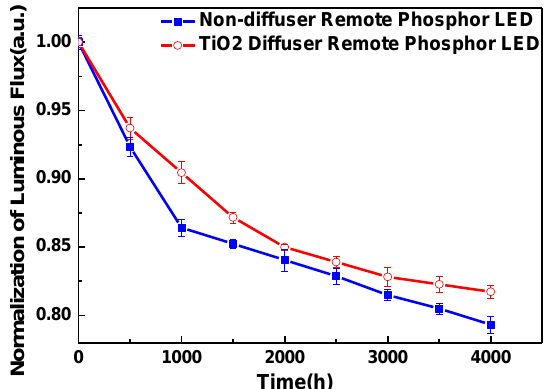
Figure 8. Reliability analysis of non-diffuser and TiO 2 diffuser-loaded encapsulation remote phosphor LEDs (350 mA injection current).